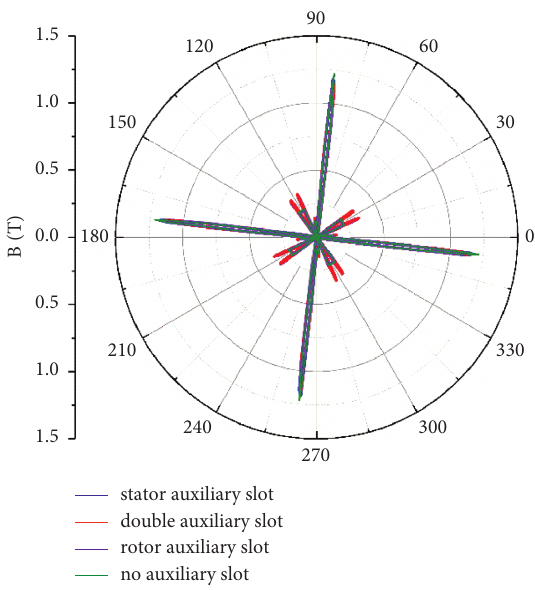
Figure 3: Distribution of flux density in the air